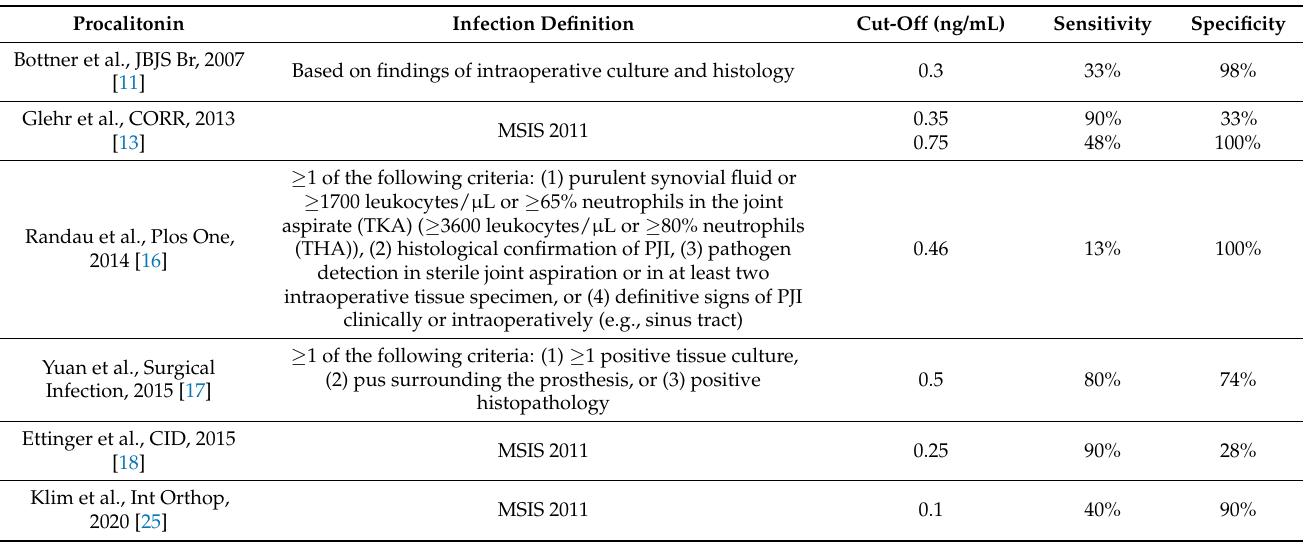
Table 7. Comparison of the literature regarding procalcitonin in the diagnosis of periprosthetic joint infection. Procalitonin